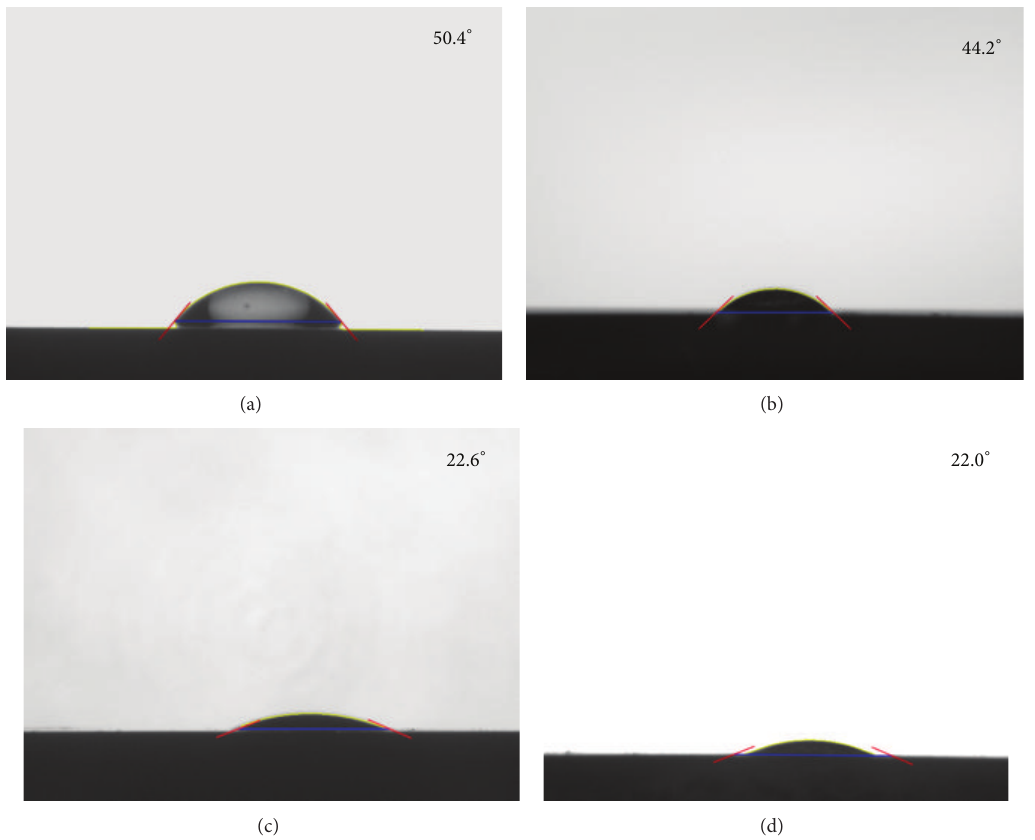
Figure 7: Contact angles of the carbon plate as model electrode (a), MWNT-modified electrode (b), COOH/MWNT-modified electrode (c), and AChE-ChOx/COOH/MWNT-modified electrode